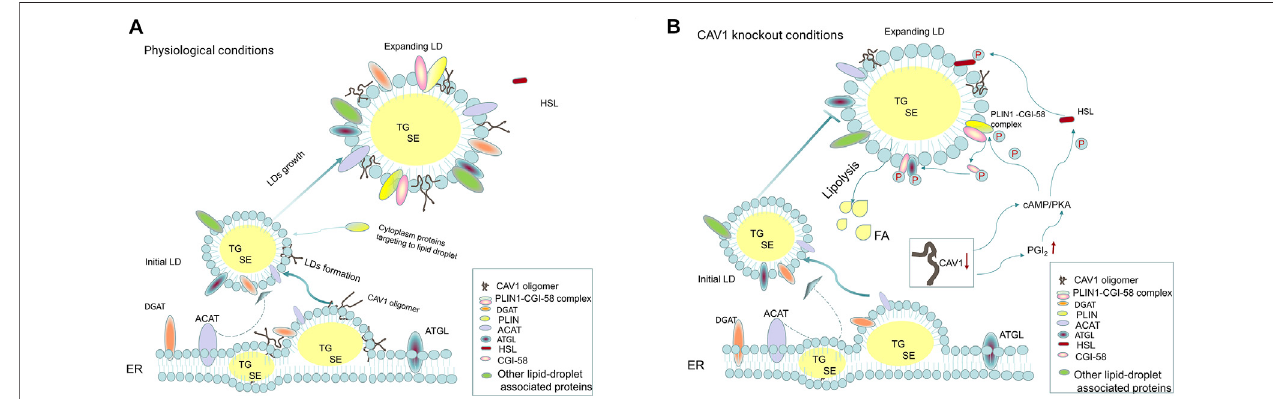
FIGURE 2 | Cav-1 and lipid droplet biogenesis. (A) Under physiological conditions, the initial step of lipid droplets (LDs) formation is the synthesis of neutral lipids (TGs and SEs) by DGAT and ACAT on the ER, which serve as the core of LDs. As the LDs gradually expand, LD-associated proteins and ER-derived monolayer phospholipids are distributed around neutral lipids, promoting the initial lipid droplets to become enlarged lipid droplets. Cytoplasmic proteins, such as PLIN family proteins,areinvolvedinregulatinglipiddropletmetabolismandcantargetthelipiddropletsurface,amongwhichPLIN1bindstoCGI-58proteintoformthePLIN1- CGI-58 complex. The newly synthesized caveolin-1 is inserted into the bilayer of the ER and fused and transferred to the LDs. Caveolin-1 is involved in LD biosynthesis; on the one hand, it may affect the distribution of phospholipids on the surface of LDs, and on the other hand, it is essential for the expansion of LDs. (B) When CAV1 is knocked out in cells (such as adipocytes and endothelial cells), the following processes may be affected: 1. growth and expansion of new lipid droplets are hindered; 2. the reduction in caveolin-1 expression can increase the phosphorylation ofHSL and PLIN1 in a cAMP-dependent manner to enhance lipolysis. The latter isregulated by the PGI2/cAMP/PKA pathway, leading to phosphorylation of PLIN1 and CGI-58. Phosphorylated CGI-58 dissociates from PLIN1 and activates ATGL to co-activate